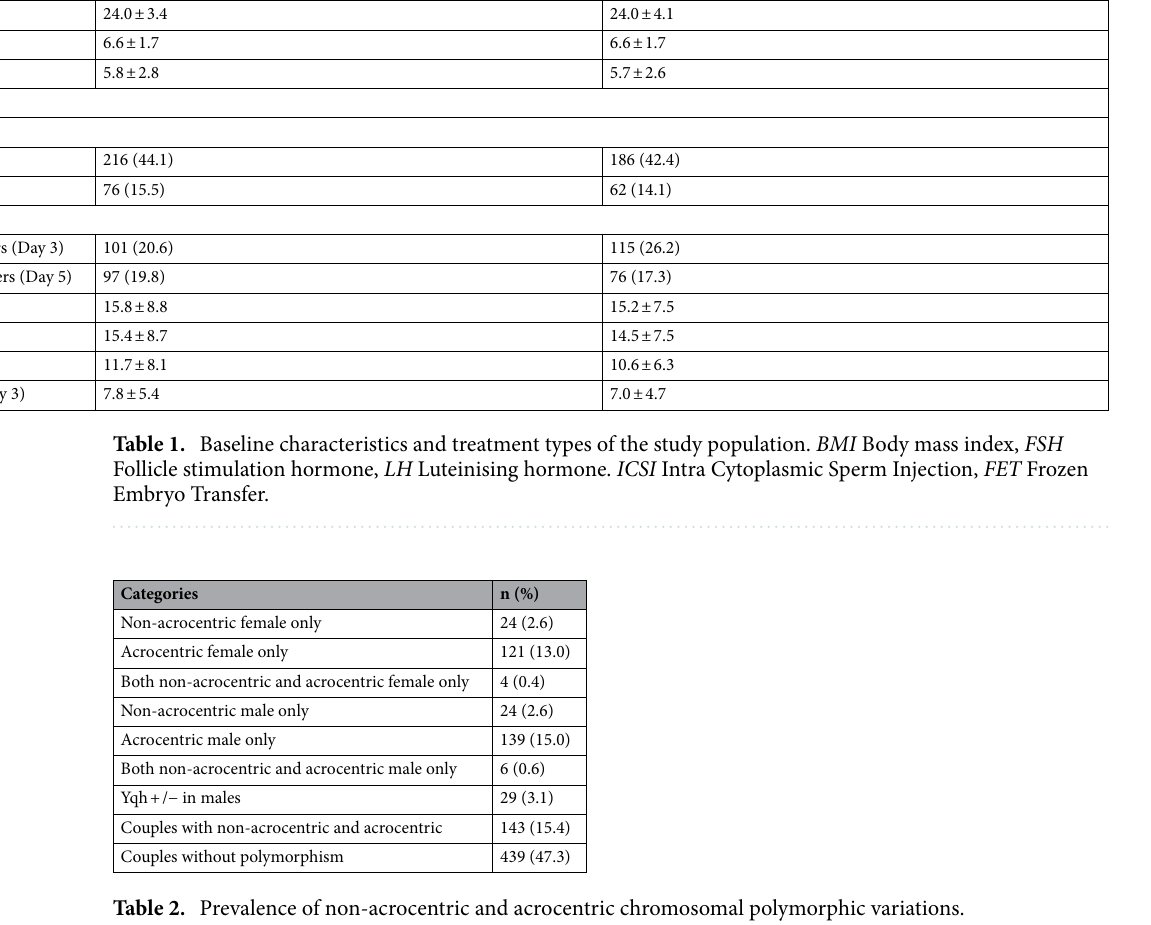
Table 2. Prevalence of non-acrocentric and acrocentric chromosomal polymorphic variations.